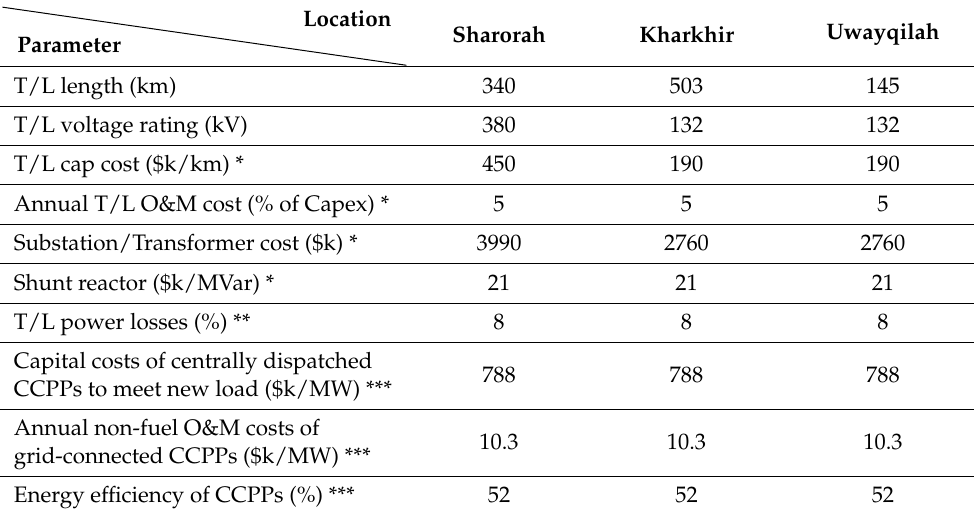
Table 2. Assumptions on technical characteristics and costs of fossil-fired combined-cycle power plants (CCPPs) and transmission